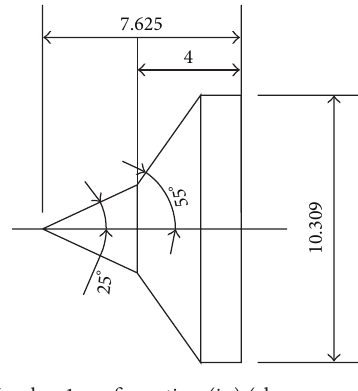
Figure 4: Number 1 configuration (in) (sharp nose 25 ∘ /55 ∘ double cone).